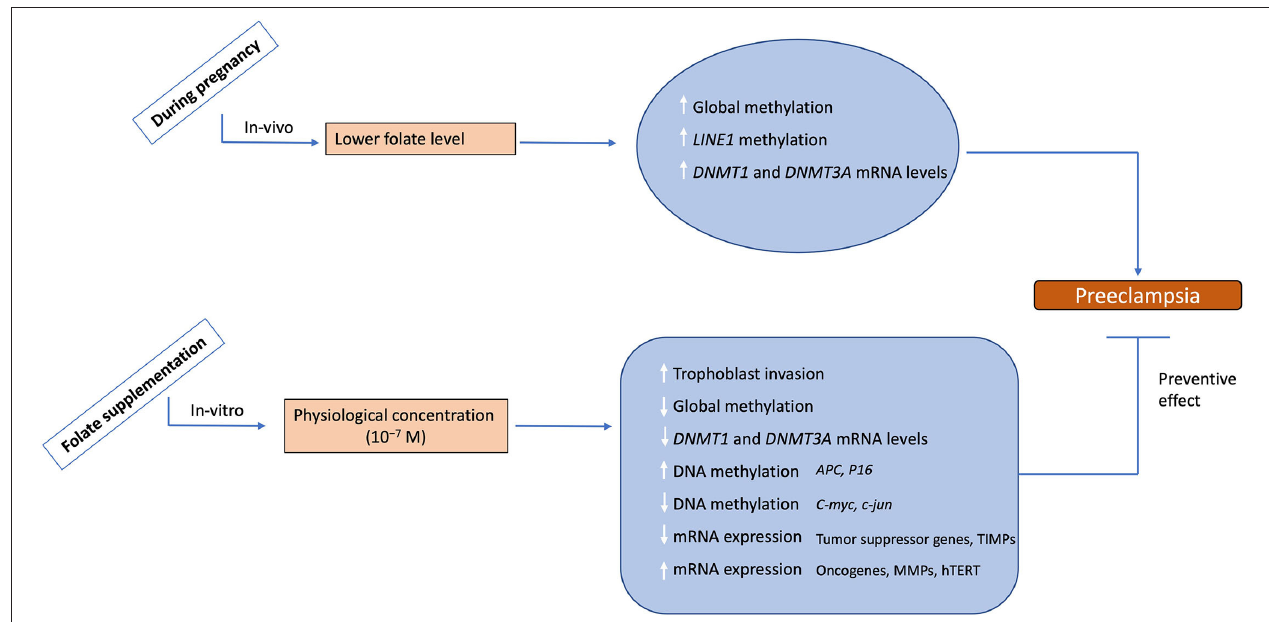
FIGURE 8 | Summary of the study. During physiological pregnancy lower levels to folate are associated with increased global methylation, LINE1 methylation and mRNA levels for DNMT1 and 3A leading to preeclampsia development. Folate supplementation at physiological levels leads to increased trophoblast invasion potential, decreased global methylation, decreased mRNA levels for DNMT1 and 3A, and alters DNA methylation/mRNA expression of various placental genes. This data demonestrates the possible role of folate supplementation in reversing the preeclampsia phenotype, hence suggesting a protective effect of folate supplementation. The upward arrows show an increase, while the downward arrows show the decrease in these